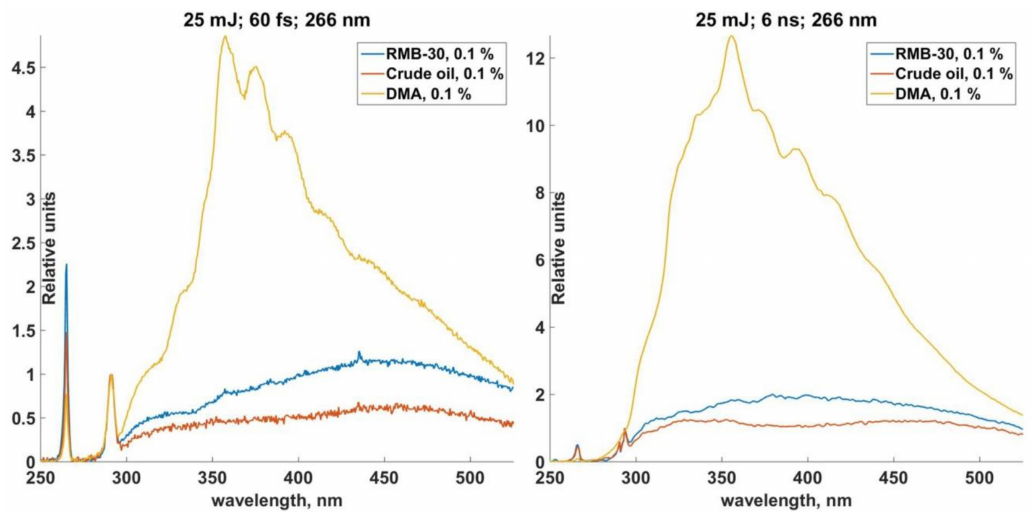
Figure 6. LIF spectrums of crude oil and